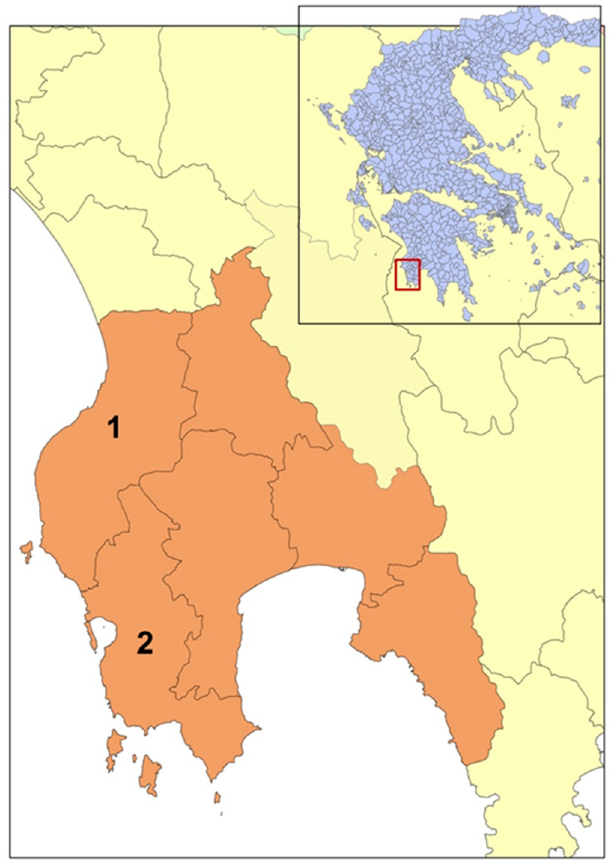
Figure 1. Messsenia with its six municipalities in south-western Greece. The interviewed farmers belonged to the Pylos-Nestor (No. 2, 36 farmers) and Trifylia (No. 1, 2 farmers) municipalities.